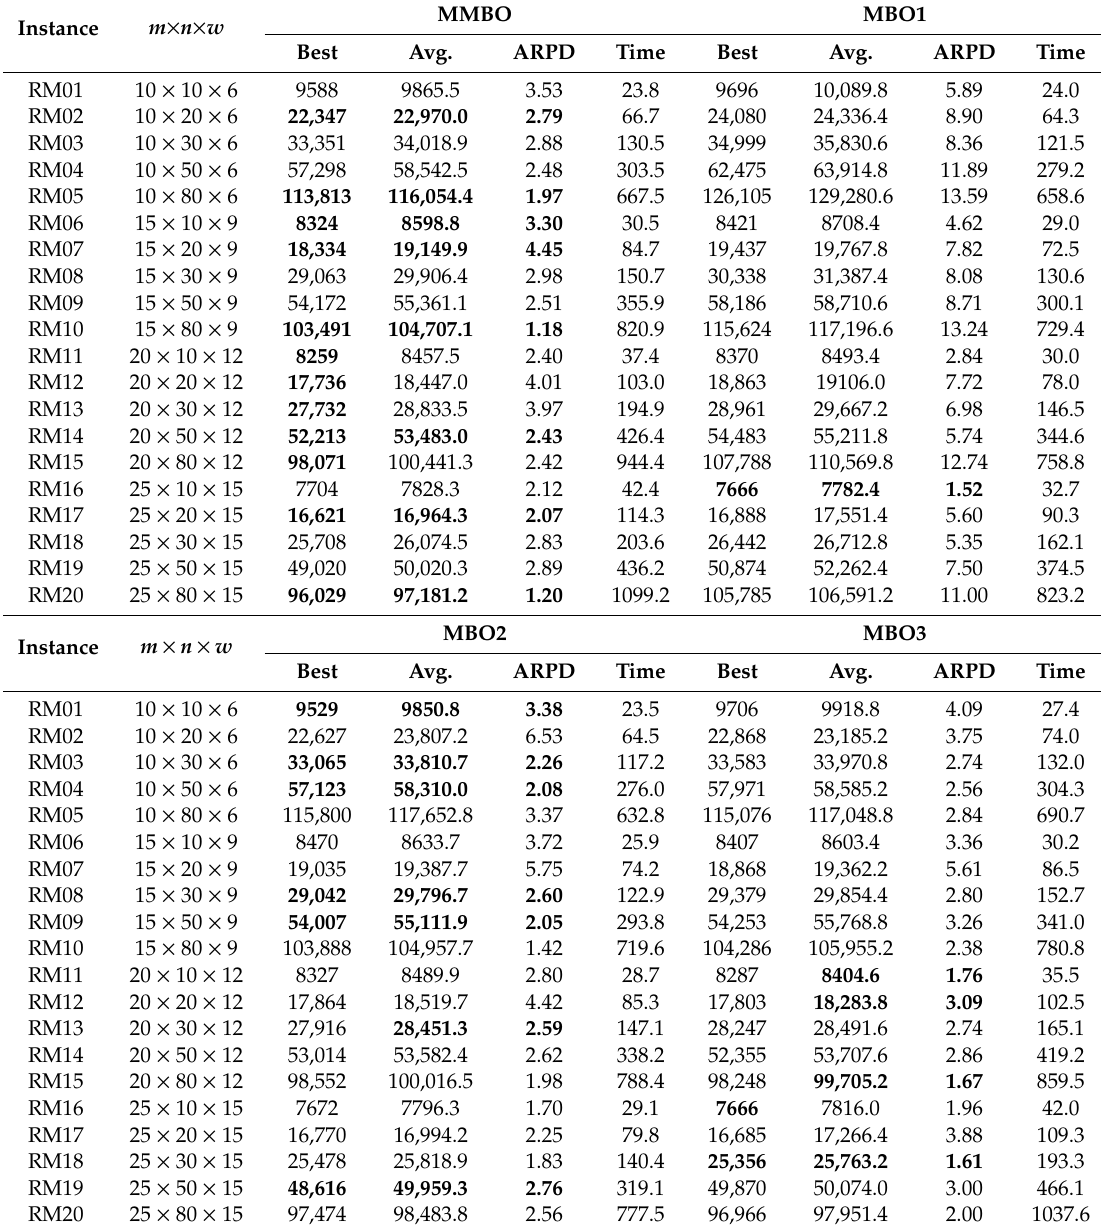
Table 2. E ff ectiveness analysis of improvement